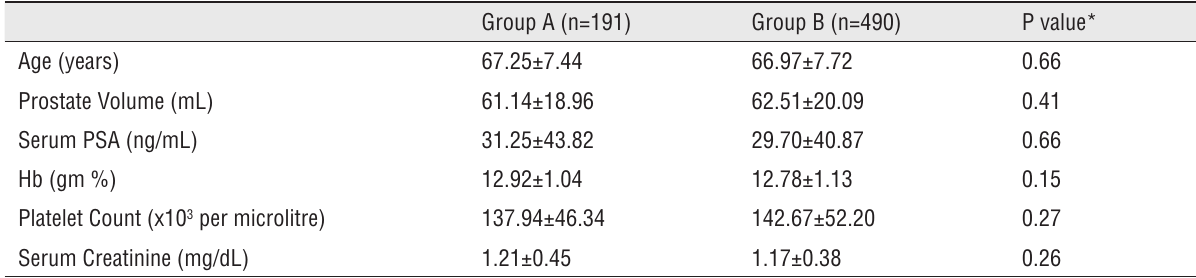
Table 1 - Baseline characteristics.